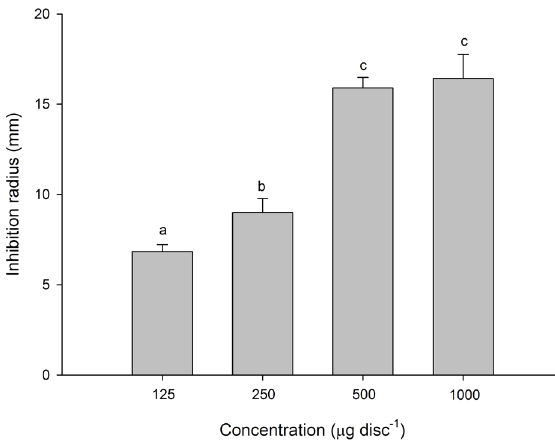
Figure 4 - Inhibition radius (mm) of Pithyum aphanidermatum exposed to different concentrations of Annona glabra extract (C group - 125, 250, 500 and 1000 µg disc -1 ). At day 10, maximal inhibition zones were observed. Bars are means ± SD for n =3, same superscript letters are not significantly different (p >